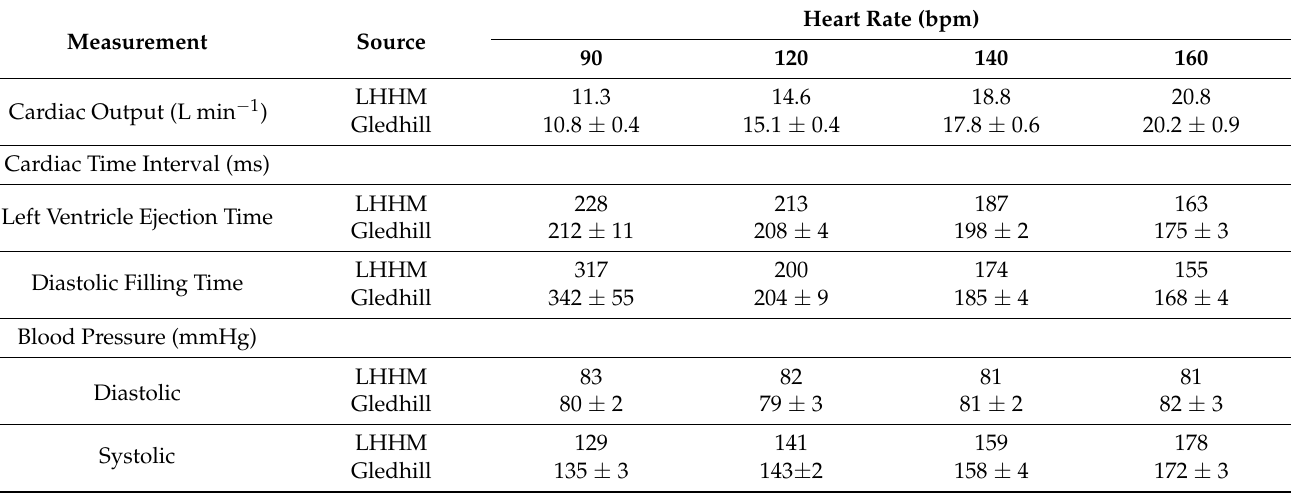
Figure 2. Pressure traces for left ventricle, left atrium and artery, as well as left ventricular volume for five cardiac cycles for simulations of heart rate related to exercise at 90 and 160 beats per minute. Table 4. Cardiac output, left ventricular ejection time, diastolic filling time and blood pressure for each heart rate predicted by LHHM and experimentally measured on untrained healthy subjects by Gledhill et al. [19].